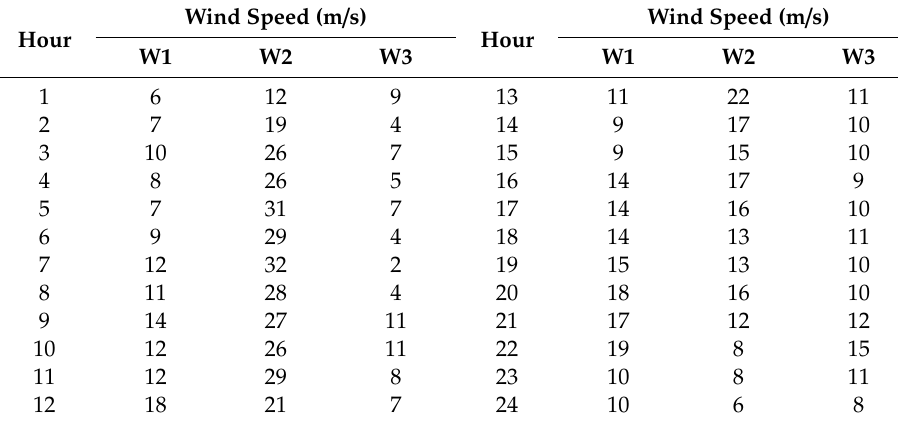
Table A5. Hourly wind speed for 24